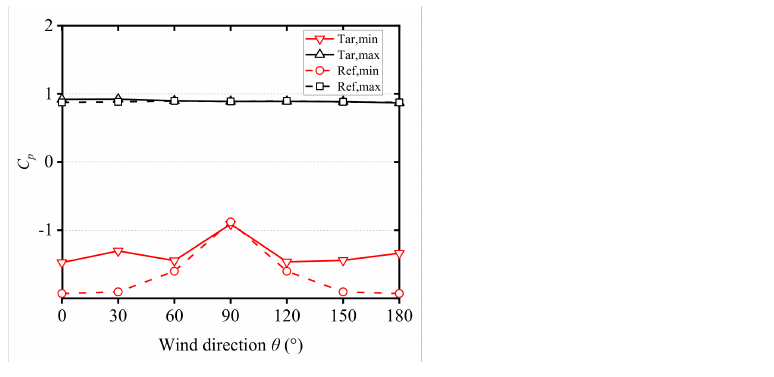
Figure 6. Wind pressure coefficient on the surface of the building facade at different wind